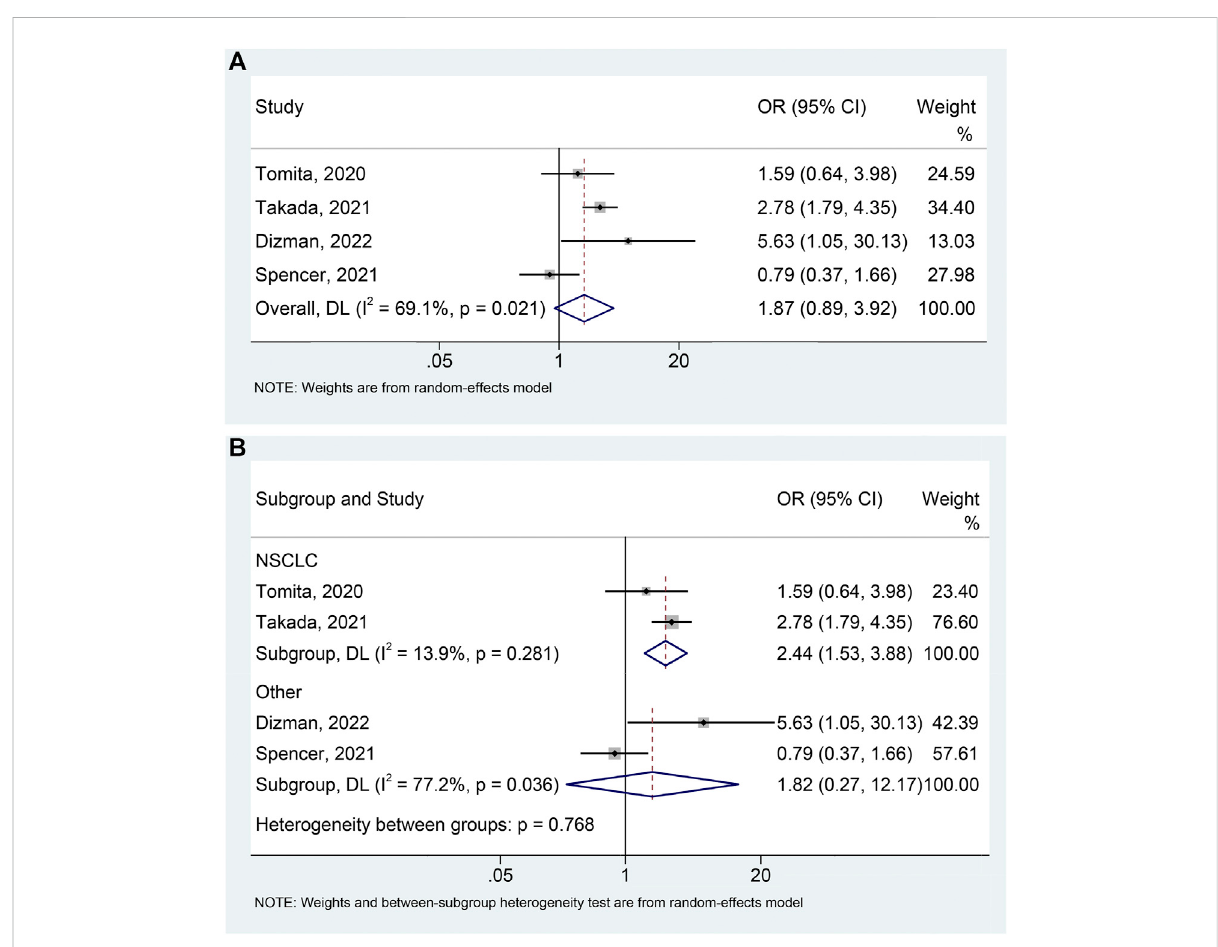
FIGURE 5 Forest plots of OR for the relationship of probiotic use with disease control rate (A) . Subgroup analysis of the disease control rate based on cancer types (B) . NSCLC, non-small cell lung cancer; OR, odds ratio; CL, con fi dence interval; Univariate analysis (Tomita et al., 2020; Dizman et al., 2022); Multivariable analysis (Spencer et al., 2021; Takada et al.,